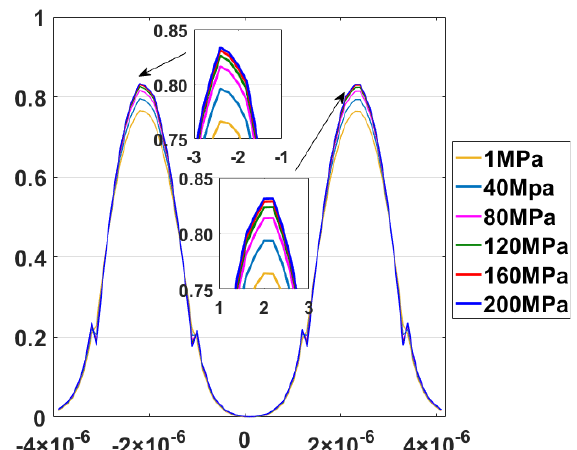
Figure 6. Intensity distribution of the axis cross-section in HE31 mode under the 1–200 MPa stress in the y direction.